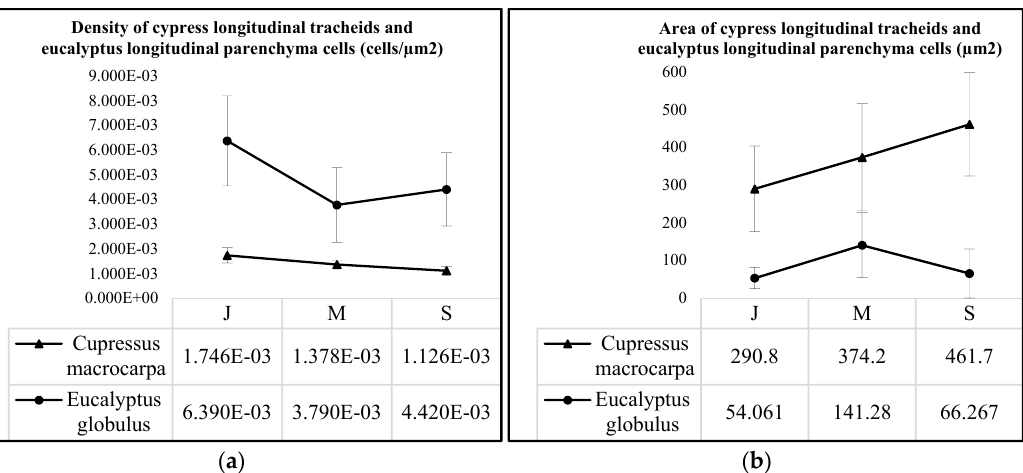
Figure 6. Average values of ( a ) density and ( b ) area of longitudinal parenchyma cells and longitudinal tracheids from Eucalyptus globulus and Cupressus macrocarpa samples, respectively, per age group, i.e., juvenile (J), mature (M) and senile (S). Forests 2020 , 11 , x FOR PEER REVIEW